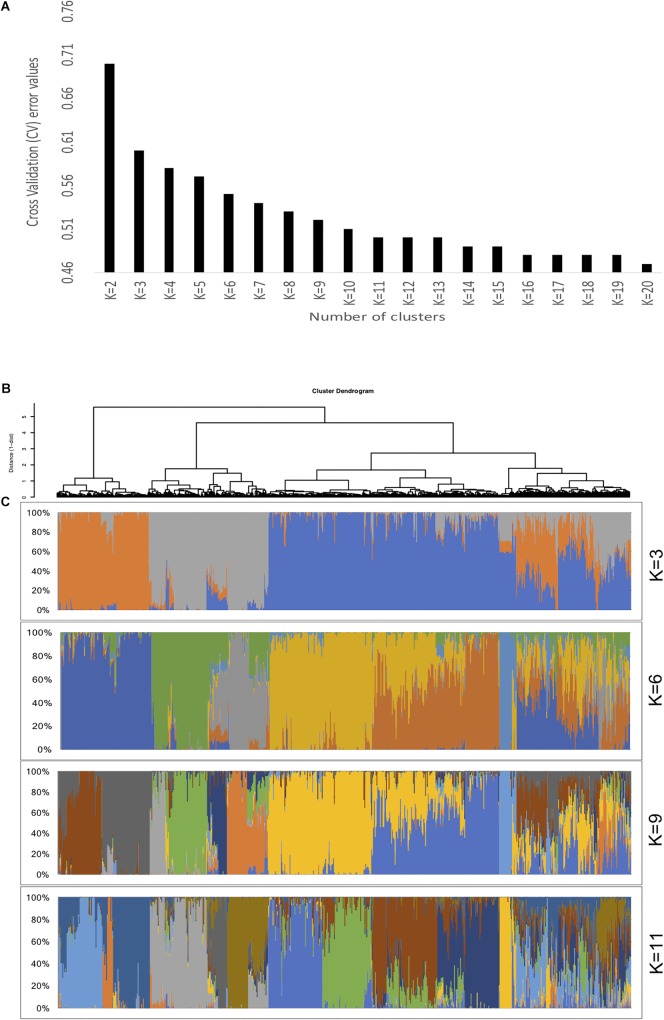
Population genetic structure of the Ethiopian sorghum landrace collection. (A) A 10-fold cross-validation (CV) error rates for K = 2 to K = 20 determined by ADMIXTURE analysis. The CV values of different K indicated steep decrease until it reached 11, showing optimal number of clusters as K = 11, (B) Hierarchical clustering (Ward’s minimum variance method) dendrogram, (C) Individual ancestry estimated based on ADMIXTURE analysis for different K-values. Each individual accession is represented as a single vertical line partitioned into segments corresponding to the inferred membership according to different K genetic clusters as indicated by the colors.